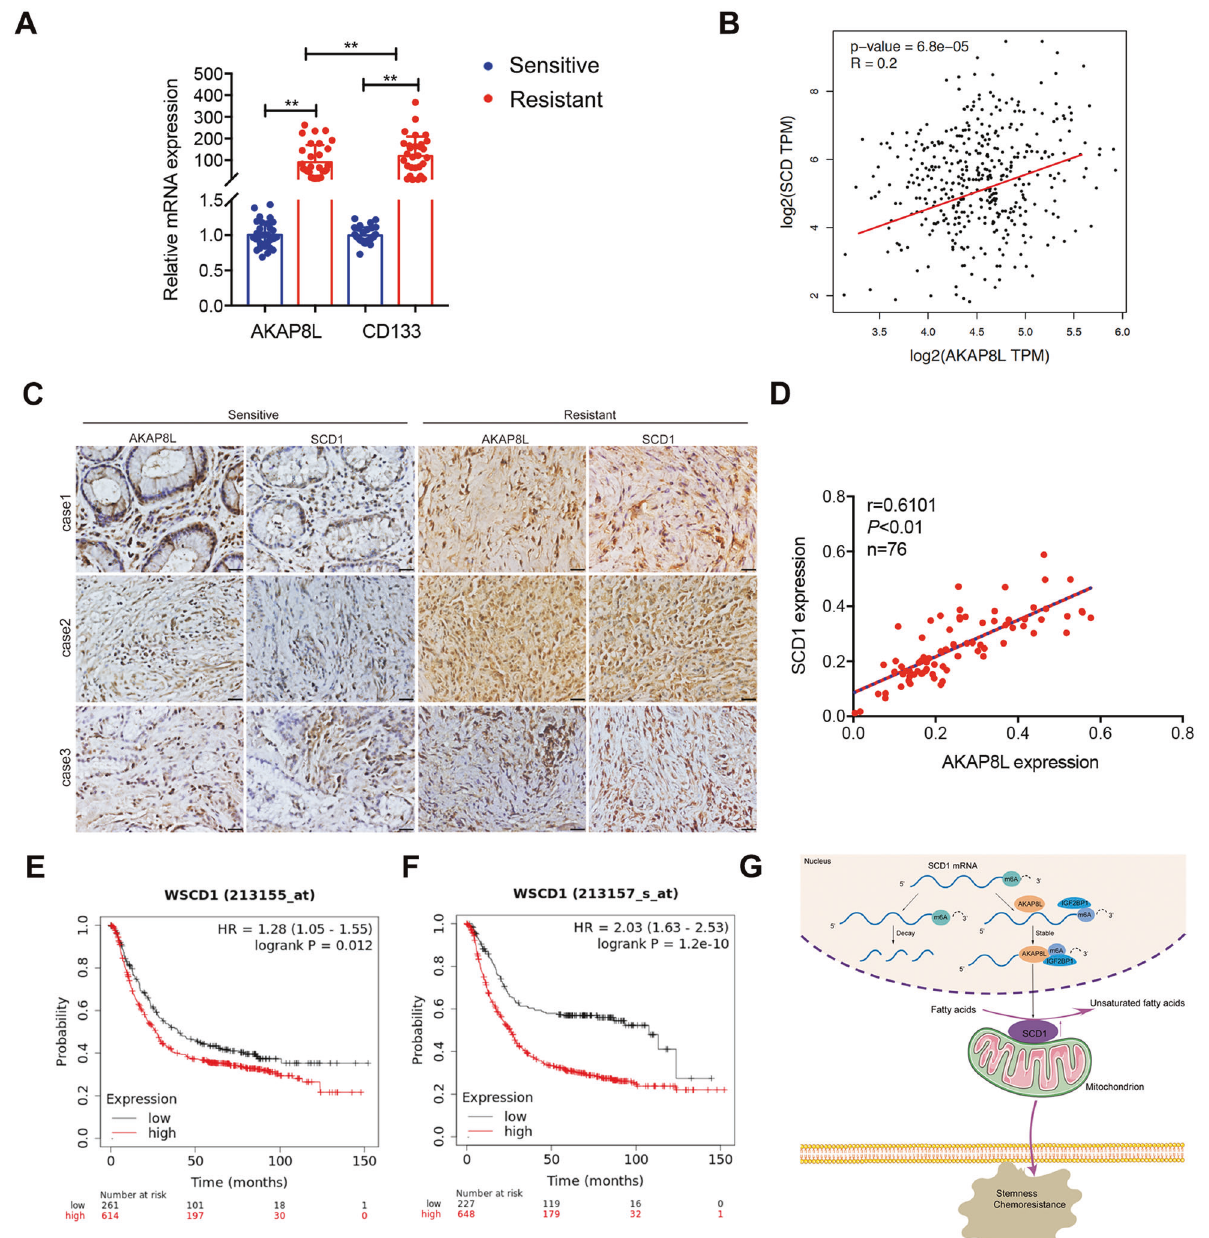
Fig. 8 AKAP8L were positively correlated with SCD1 in GC tissues. A Expression of AKAP8L and SCD1 in fresh tumor tissues collected from gastric cancer patients sensitive ( n = 31) or resistant ( n = 45) to chemotherapy detected by qPCR. B Correlation between AKAP8L and SCD1 mRNA expression levels, based on GEPIA data analysis. C Representative images showing the expression of AKAP8L and SCD1 detected by IHC in paraf fi n-embedded gastric tumor tissues ( n = 76). D Correlation between AKAP8L and SCD1 expression levels. Two-tailed Spearman ’ s correlation analysis ( n = 76). E , F Analysis of the SCD1 expression in relation to the overall survival of GC patients from Kaplan – Meier plotter database (213155_at and 213157_s_at). G A schematic model showing the role of the AKAP8L in GC stemness and chemoresistance. * P < 0.05, ** P < 0.01, *** P <